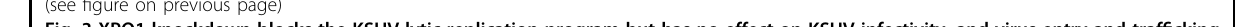
Fig. 3 XPO1 knockdown blocks the KSHV lytic replication program but has no effect on KSHV infectivity, and virus entry and traf fi cking during primary infection. A HUVEC were infected with lentiviruses expressing shRNAs targeting XPO1 (shXPO1-1 and shXPO1-2) or control shRNA (shCtrl). Cells were selected with puromycin (1 µg/ml) for 48 h and analyzed by Western-blotting to monitor the knockdown ef fi ciency. β -actin was used as the loading control. B , C HUVEC with XPO1 knockdown were infected with KSHV for 96 h. Supernatants were collected and used to titrate infectious virions by infecting fresh HUVEC. At 48 hpi, representative images were taken ( B ) and used for quantifying the numbers of GFP-positive cells ( C ). D HUVEC with XPO1 knockdown were infected with KSHV for 48 h. Cells were fi xed and stained for LANA (red). The expression level and pattern of LANA are shown. Nuclei were stained with DAPI. Images were taken with a confocal microscopy (magni fi cation ×600). E Quanti fi cation of LANA-positive cells based on images taken as described in ( D ). F HUVEC with knockdown of XPO1 were infected with KSHV for 6 h, fi xed, and stained for nuclei with DAPI (blue) and KSHV particles with an antibody to ORF65 (red). Images were taken with a confocal microscopy (magni fi cation ×1000). G The total number of KSHV particles successfully docked at the perinuclear region of each nucleus was quanti fi ed and analyzed based on images taken as described in ( F ). H HUVEC with XPO1 knockdown infected with KSHV for 6 h were collected and analyzed for viral genome copy numbers by qPCR using LANA primers. I – L HUVEC with XPO1 knockdown were infected with KSHV and then collected for RNA extraction at 48 hpi. The expression levels of KSHV transcripts were then examined by RT-qPCR. M HUVEC with XPO1 knockdown were infected with KSHV and collected at 48 hpi. The expression of viral proteins was then analyzed by Western blotting. β -actin was used as a loading control. *, **, and *** indicate P values of < 0.05, < 0.01, and < 0.001, respectively; NS not signi fi